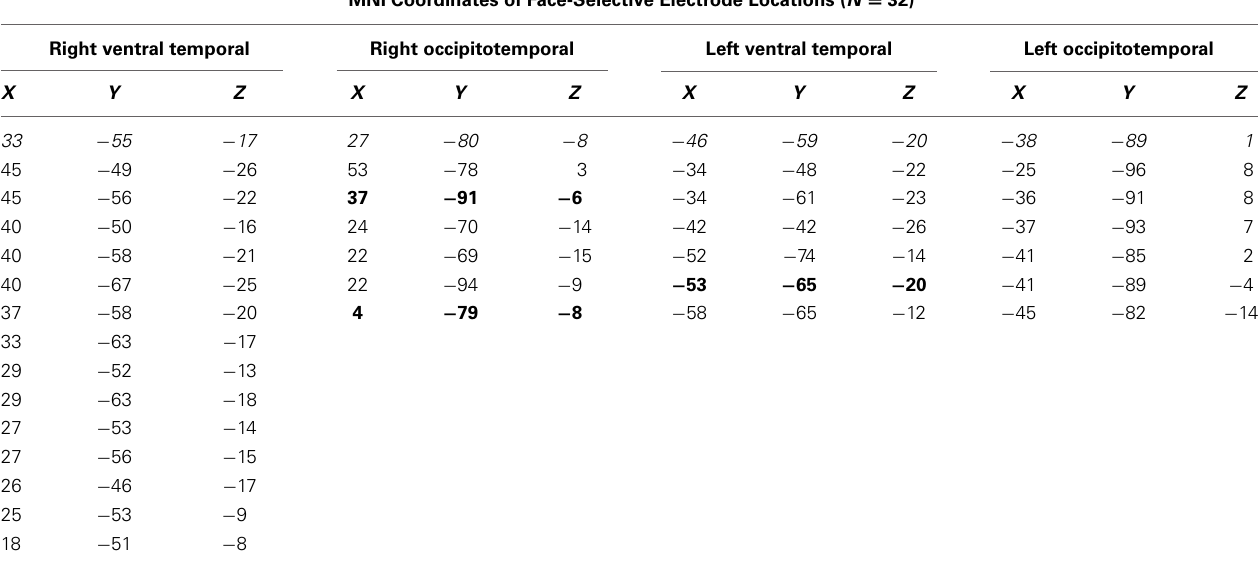
Table 1 | Electrode locations of face-selective sites within each spatial cluster. MNI Coordinates of Face-Selective Electrode Locations ( N = 32) Right ventral temporal Right